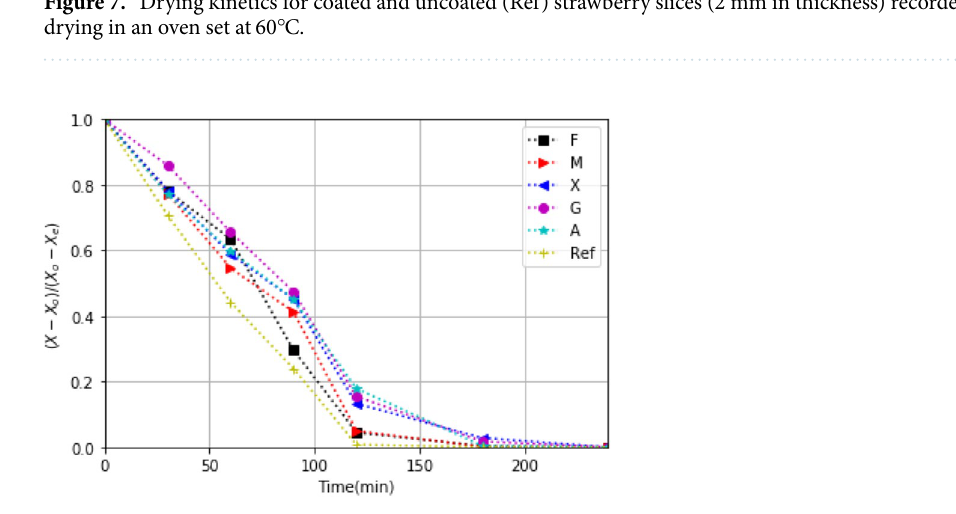
Figure 8. Drying kinetics under the solar drying process for strawberry slices (2 mm) with the edible coatings coating and without it